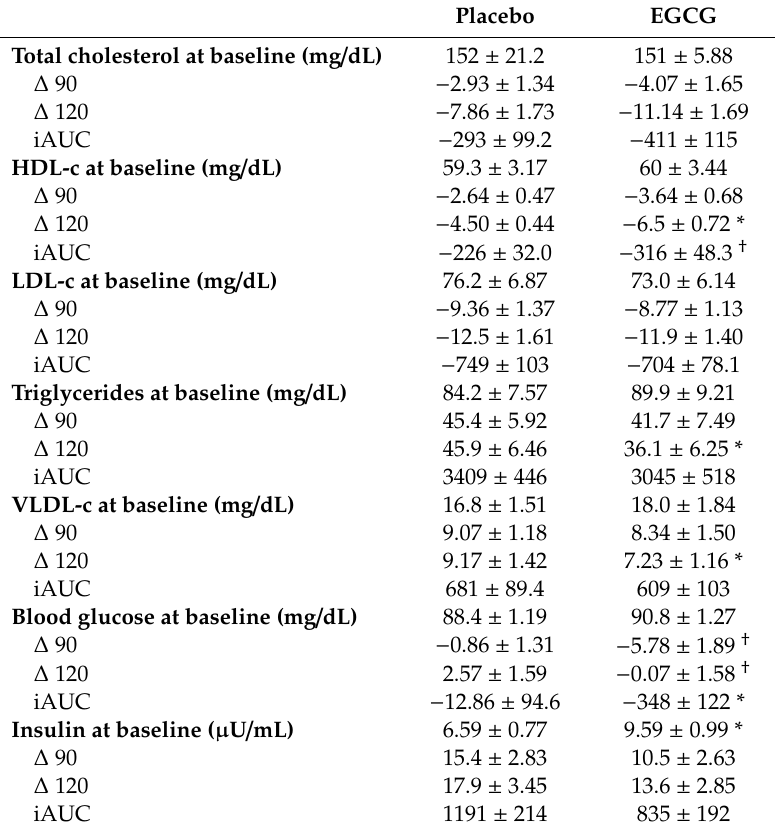
Table 2. The response of the epigallocatechin-3-gallate supplementation after a high-fat fast-food